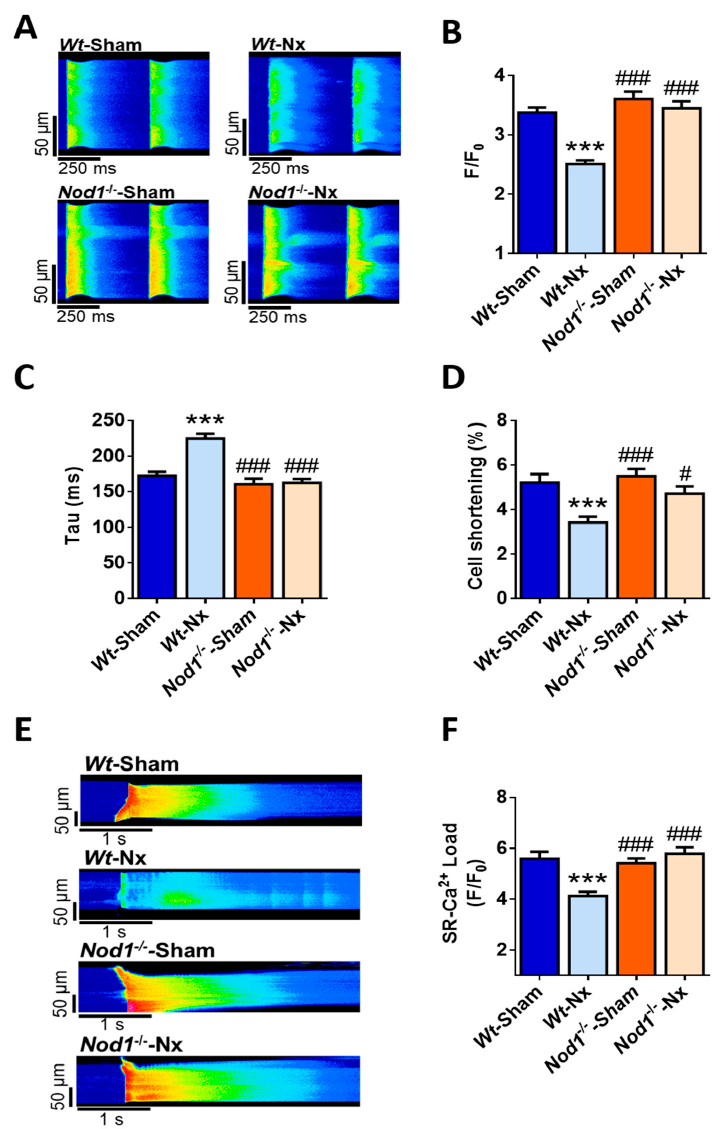
Figure 1. Deficiency of nucleotide-binding oligomerization domain-containing protein 1 (NOD1) prevents the dysregulation of systolic Ca 2+ release, cell contraction impairment and the reduction in sarcoplasmic reticulum (SR) Ca 2+ -load triggered by 5/6 nephrectomy. ( A ) Representative line-scan confocal images of Ca 2+ transients in cardiomyocytes from Wt -sham, Wt -Nx, Nod1 − / − -sham and Nod1 − / − -Nx mice electrically evoked by field stimulation at 2 Hz. Mean values of ( B ) peak fluorescence of Ca 2+ transients, ( C ) decay time constant and ( D ) cell shortening obtained in cells from Wt -sham ( n = 45 cells/five mice), Wt -Nx ( n = 43 cells/five mice), Nod1 − / − -sham ( n = 39 cells/five mice) and Nod1 − / − -Nx ( n = 50 cells/five mice) mice. ( E ) Representative line-scan confocal images of caffeine-evoked Ca 2+ transients in cardiomyocytes from all groups. ( F ) Mean values of caffeine-evoked Ca 2+ transients amplitude obtained in cells from Wt -sham ( n = 33 cells/five mice), Wt -Nx ( n = 37 cells/five mice), Nod1 − / − -sham ( n = 34 cells/5 mice) and Nod1 − / − -Nx ( n = 35 cells/5 mice) mice. Results show mean ± SEM. *** p < 0.001 vs. Wt -sham; # p < 0.05, ### p < 0.001 vs. Wt -Nx.